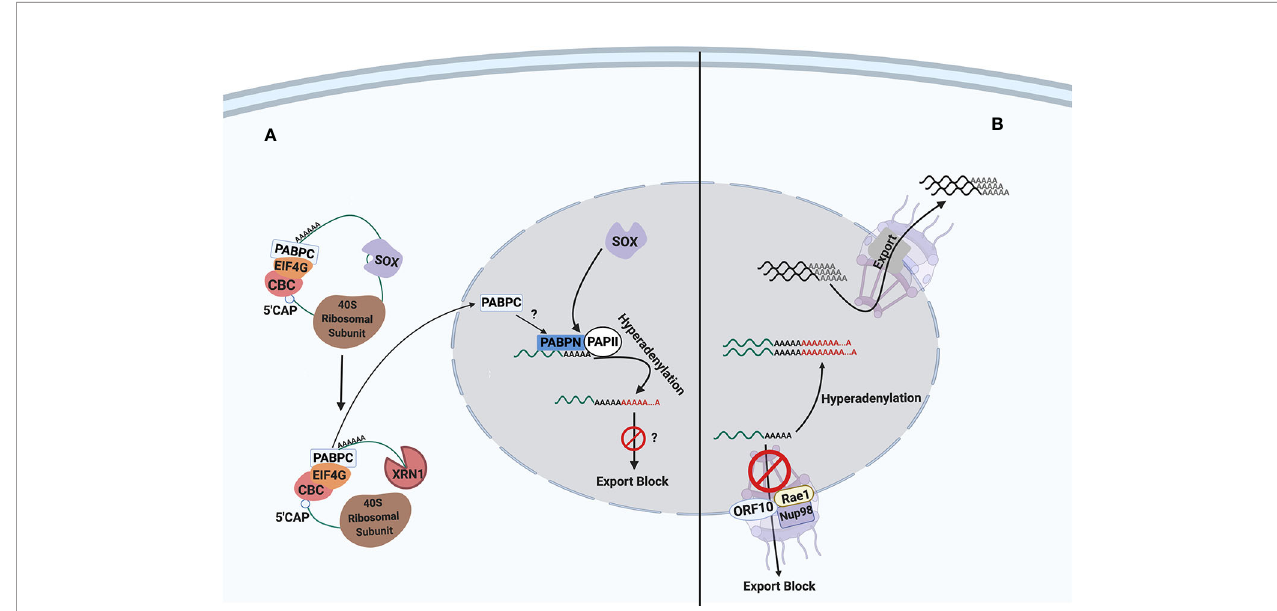
FIGURE 1 | The inhibitory mechanisms of SOX and ORF10 proteins on host gene expression. SOX protein targets transcripts for degradation, affecting both the host and viral transcripts. On the other hand, ORF10 acts solely on cellular transcripts for export inhibition. Interestingly, both SOX and ORF10 cause the hyperadenylation of transcripts within the nucleus. (A) Cytoplasmic SOX protein, as encoded by ORF37, causes host shut off through its endonuclease activity. The viral endonucleolytic action on host transcript then triggers the cellular exonuclease, Xrn1, to complete transcript degradation. (B) At the nuclear envelope, ORF10 inhibits only the export of host transcripts by forming a complex with cellular export factor Rae1 and its partnering nucleoporin, Nup98. The hijacking of Rae1-Nup98 leads to nuclear retention of mRNAs. CBC, cap-binding complex; PABPC, cytoplasmic poly(A)-binding protein; PABPN, nuclear poly(A)-binding protein; PAPII, poly (A) polymerase II. Question marks indicate potential or hypothetical mechanisms and effects within the